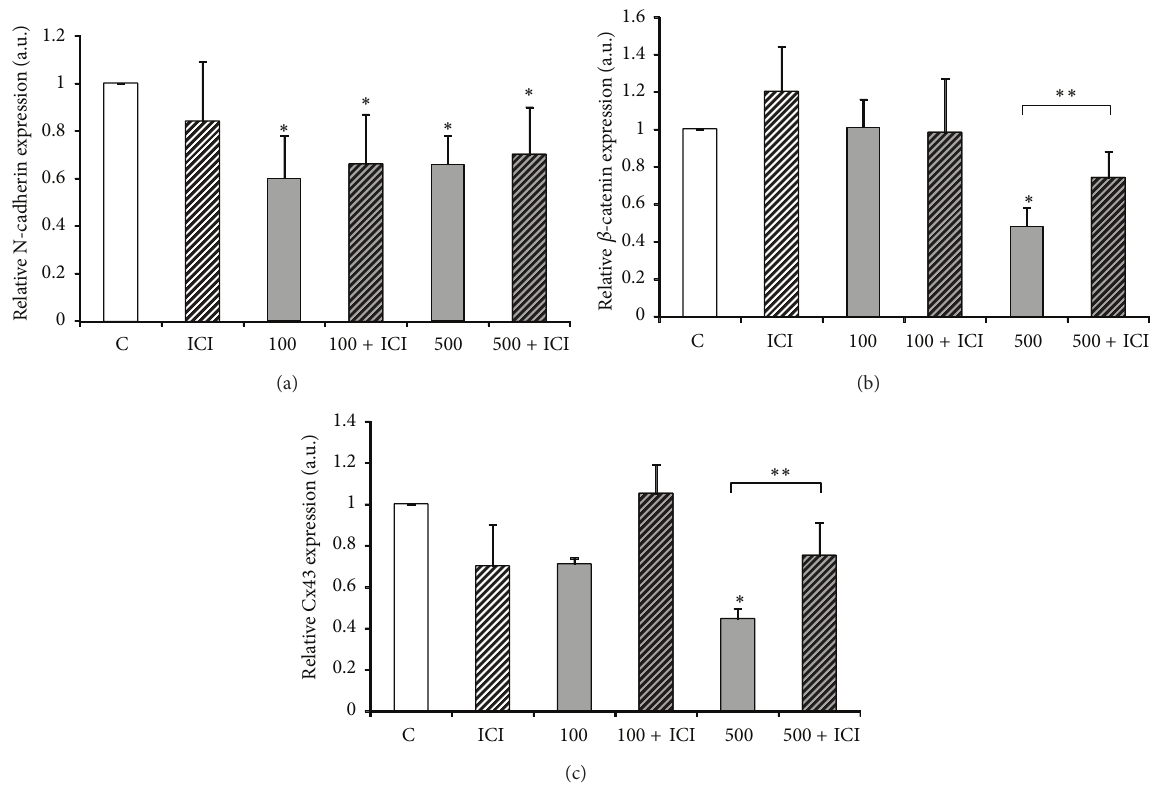
Figure 5: The effects of ICI 182,780 on octylphenol-induced decrease of N-cadherin (a), 𝛽 -catenin (b) and connexin 43 (c) protein expression in homogenates of testis explants from bank voles kept in long light cycles ( 𝑛 = 8 ). Explants were cultured in control medium (c) or in media containing 6mg/L ICI 182,780 (ICI); 100 or 500mg/mL 4- tert -octylphenol (100, 500); 100 or 500mg/mL 4- tert -octylphenol and 6mg/L ICI 182,780 (100+ICI; 500+ICI) for 24h. Graphs represent the relative amount of N-cadherin (b), 𝛽 -catenin (c), and connexin 43 (d) protein normalized to 𝛽 -actin. Data obtained from three separate analyses is expressed as mean ± SD. Significant differences from control values are denoted as ∗ 𝑃 < 0.05 and ∗∗ 𝑃 < 0.01